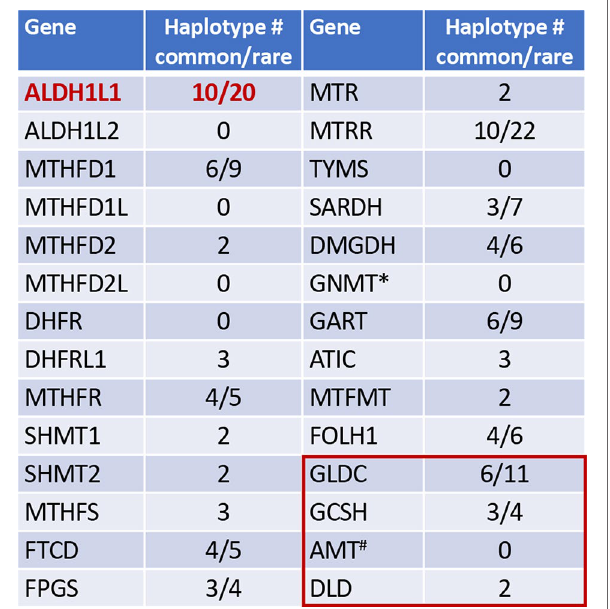
FiGURe 1 | Numbers of common and rare haplotype alleles in genes of folate metabolism (human genome assembly GRCh37/hg19; rare haplotypes have frequency below 1%). *, GNMT is the enzyme regulated by folate. Red box indicates four enzymes of the mitochondrial glycine cleavage system, # , the folate dependent enzyme in glycine cleavage. Haplotypes were analyzed using UCSC Genome Browser